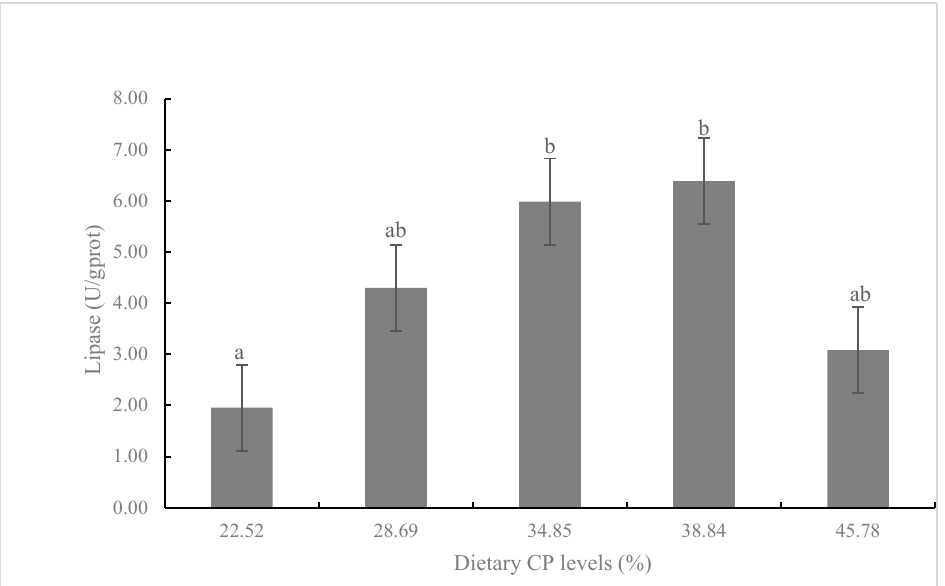
Figure 3. Lipase activity of juvenile K. punctatus fed diets containing different CP levels. Value columns with different letters mean significant difference ( p < 0.05).